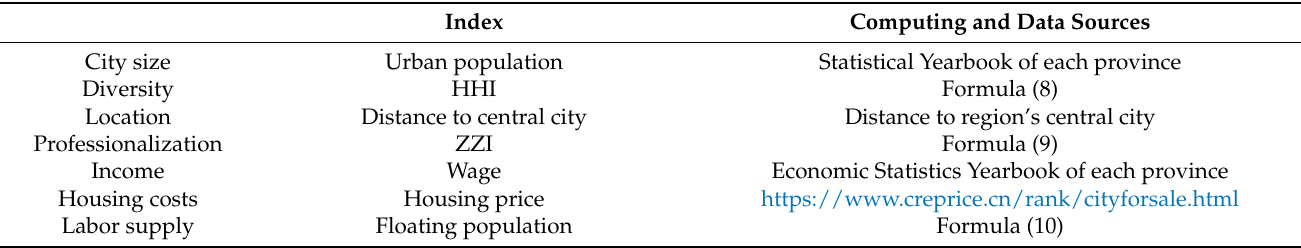
Table 1. Index selection, computing, and data sources.